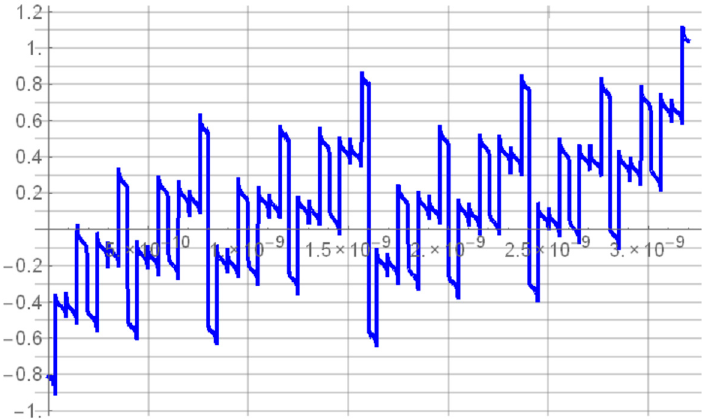
Figure 31. Total delay error normalized to LSB ( T 0 ) introduced by multiplexers S Si and S Ri vs. input time interval T In for 8-bit SA-TDC with T m equal to 350 ps.